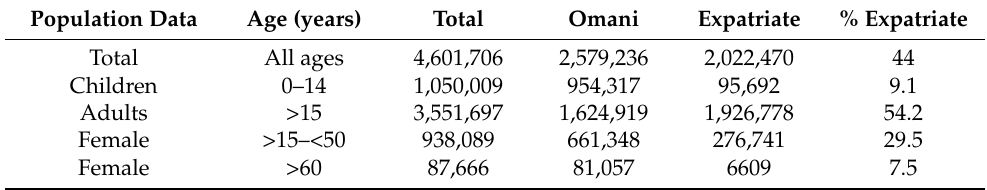
Table 1. Omani population demographics data from the annual health report